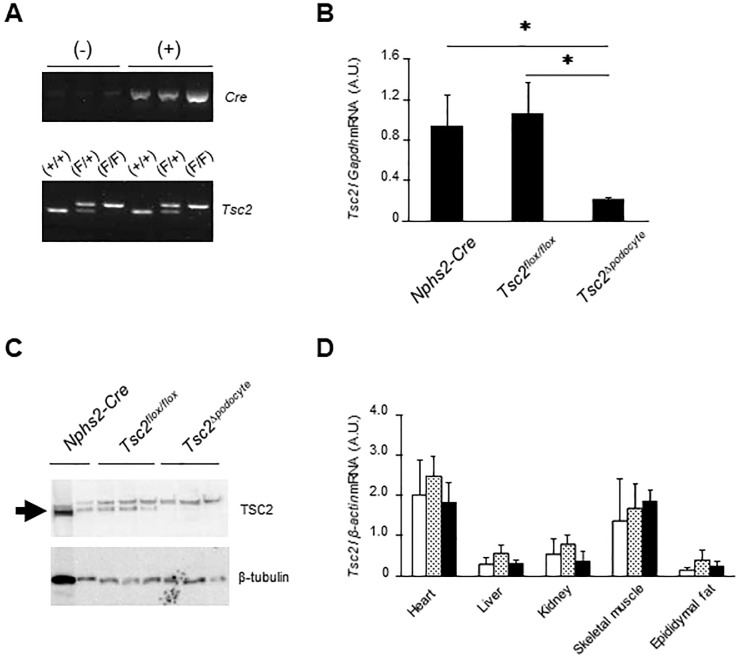
Generation of podocyte-specific Tsc2 knockout mice, Tsc2Δpodocyte. Homozygous floxed Tsc2 mice were crossed with Nphs2-Cre transgenic mice to generate Tsc2Δpodocyte, Nphs2-Cre+/-; Tsc2flox/flox.(A) PCR genotyping of genomic DNA from mouse tails. NPHS2-Cre+/-, Tsc2wt/wt mice (Nphs2-Cre) and NPHS2-Cre-/-, Tsc2flox/flox mice (Tsc2flox/flox) were used as controls. F, flox; +, wt. (B) Primary cultured podocytes isolated from Tsc2Δpodocyte and wild-type control mice at 4 weeks of age demonstrated that Tsc2 mRNA was knocked down by over 80% in the podocytes of Tsc2Δpodocyte mice compared with control mice. Results are expressed as means ± s.d. *P < 0.05 compared with age-matched controls. (C) Western blot analysis of primary cultured podocytes isolated from Tsc2Δpodocyte and control mice. TSC2 gives a band at 200 kDa (arrow). Non-specific bands were also detected above the TSC2 band in all samples. β-Tubulin was used as an internal control. (D) Tsc2 mRNA expression in various tissues of Tsc2Δpodocyte and wild-type controls. Expression levels of Tsc2 mRNA in Tsc2Δpodocyte were comparable with those in controls in all the tissues examined, including the renal cortex. White bar, Nphs2-Cre; dotted bar, Tsc2flox/flox; black bar, Tsc2Δpodocyte.